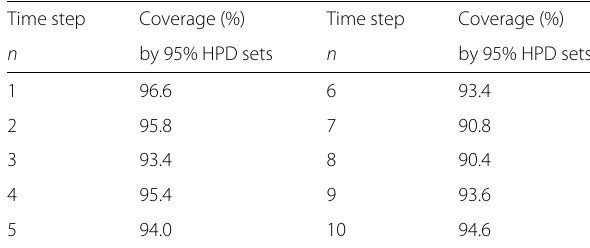
Table 10 Coverage probabilities (expressed as percentage) of the 95% HPD confidence set based on the filtered densities at each time point n in Example 2 (the Lorentz 63 model)